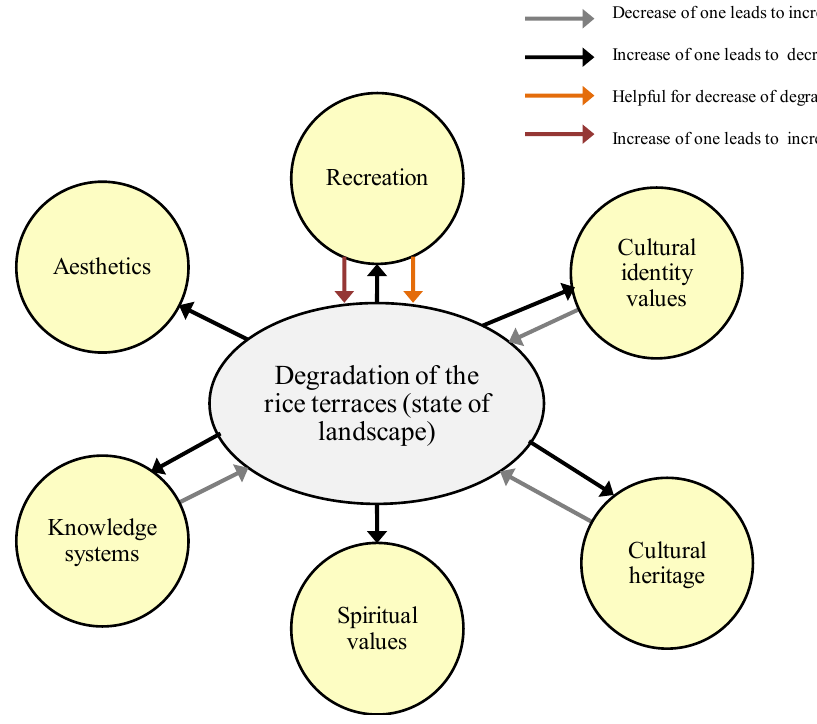
Figure 6. Interrelations between different CESs and the state of the landscape. Source: Own elaboration.